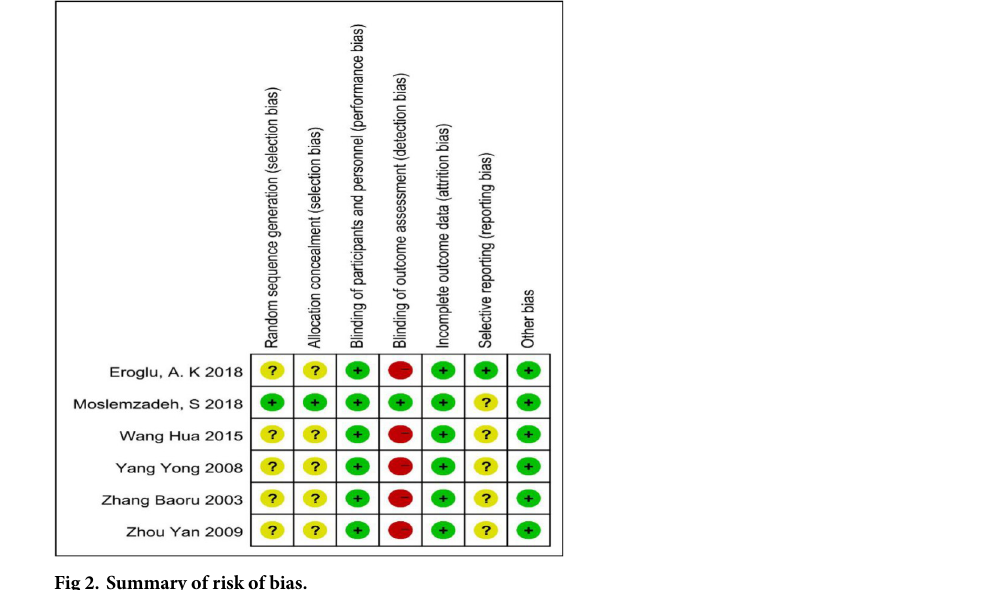
Fig 2. Summary of risk of